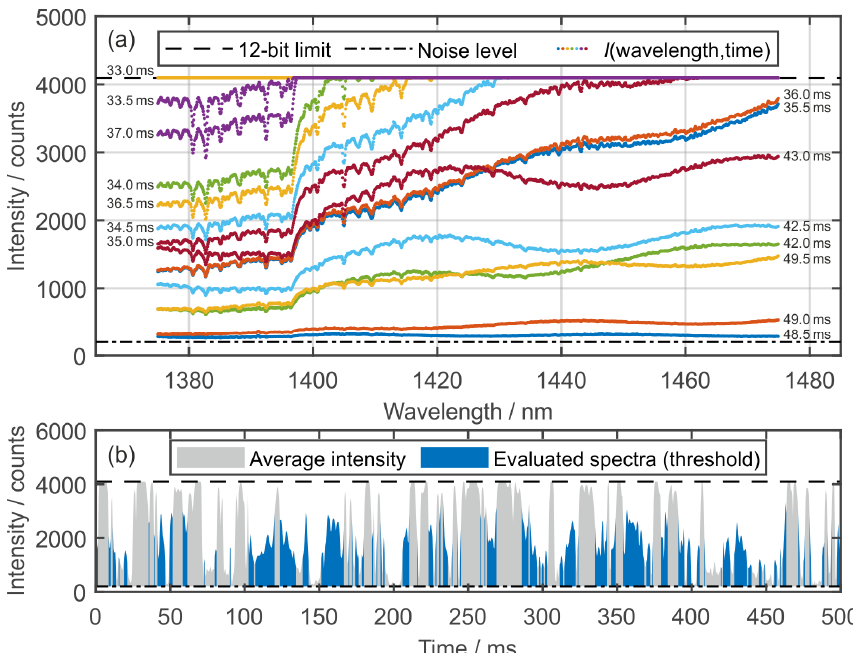
Figure 2. Examples of detected spectrometer signals (1 vol. % 1-MN in isooctane, 1 MPa 900 K, τ res = 315 ms, X H2O = 0.98%). ( a ) Typical transmission spectra I (colors represent single frames at manual selected time steps, smoothed) with temporal variations in signal intensity; and, ( b ) temporal course of spectral averaged signal intensity and fraction of evaluated (threshold filtered) spectra.